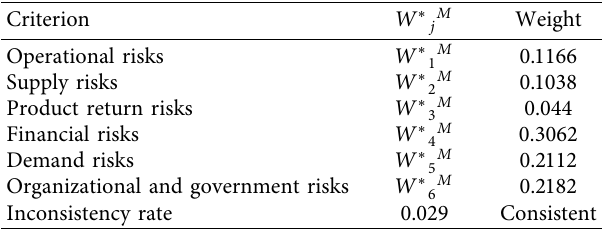
Table 6: The average weights of the main research dimensions.